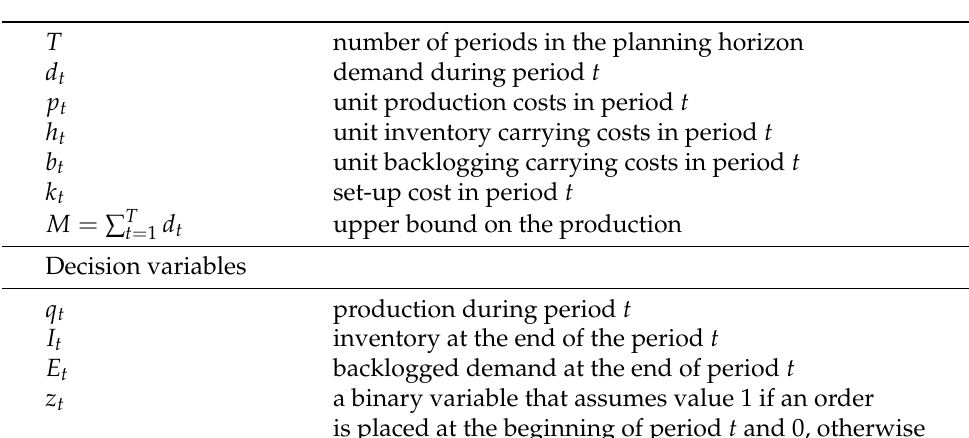
Table 1. Notation